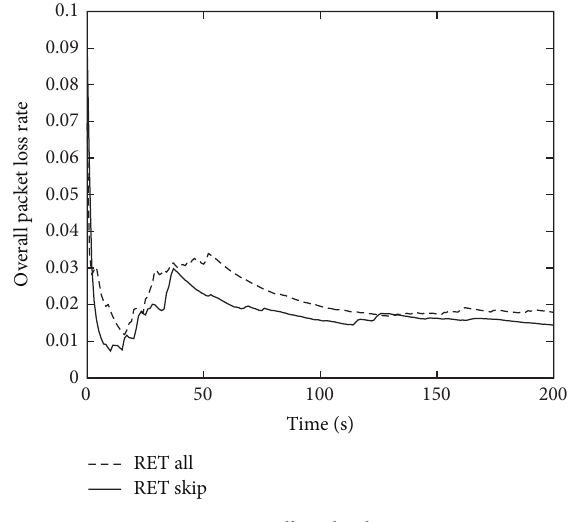
Figure 8: Overall packet loss